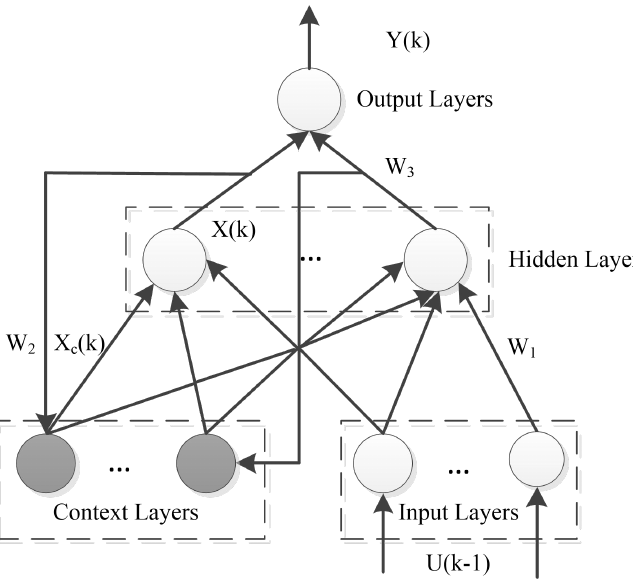
Figure 3. Elman neural network structure.